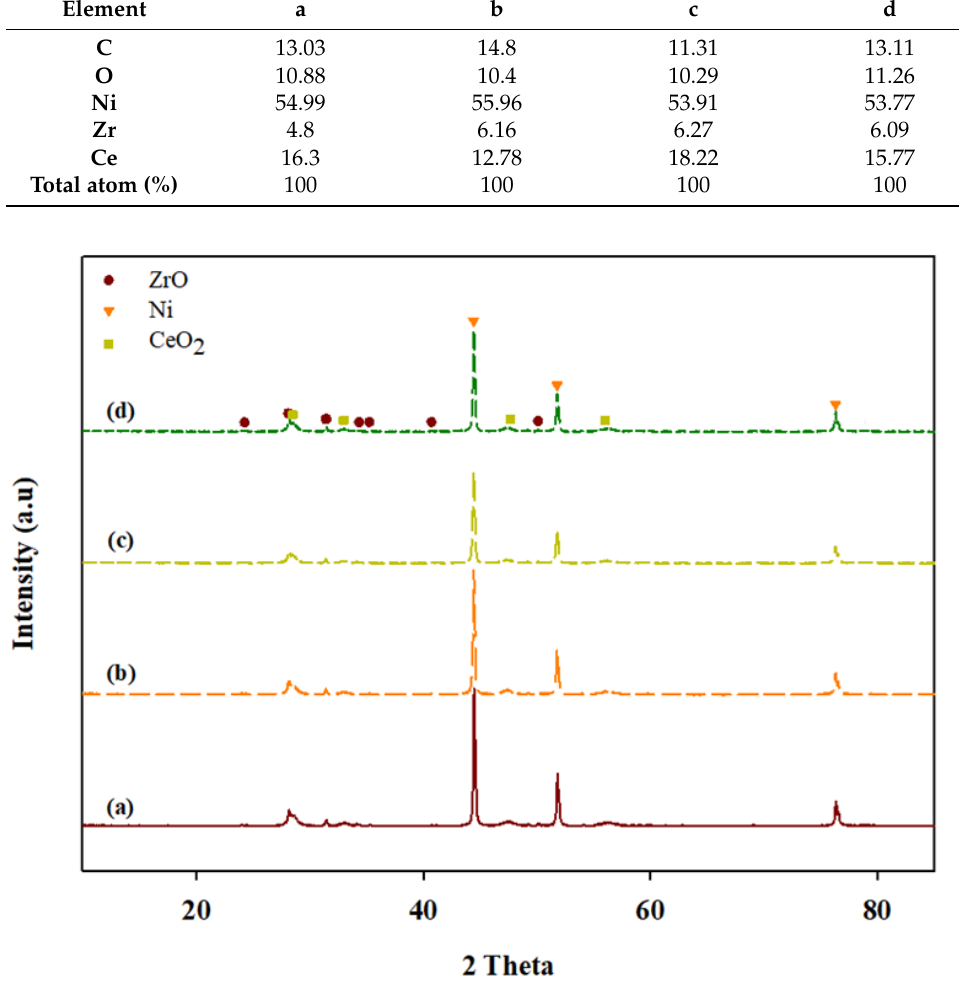
Figure 11. XRD patterns of the (a – d)